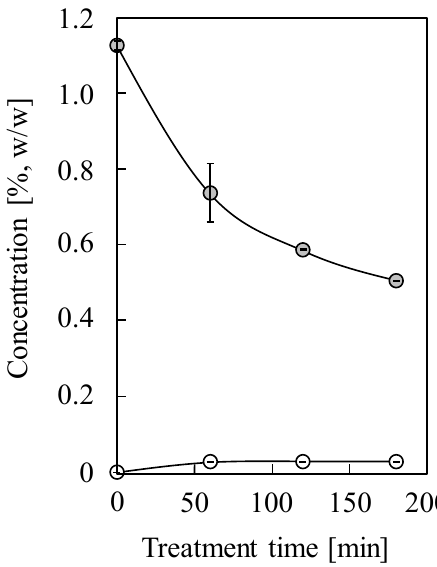
Figure 3. Conversion of piperitone (grey cycle) to thymol (white cycle). The subcritical water treatments were carried out at 240 °C for 0, 60, 120, and 180 min, respectively.